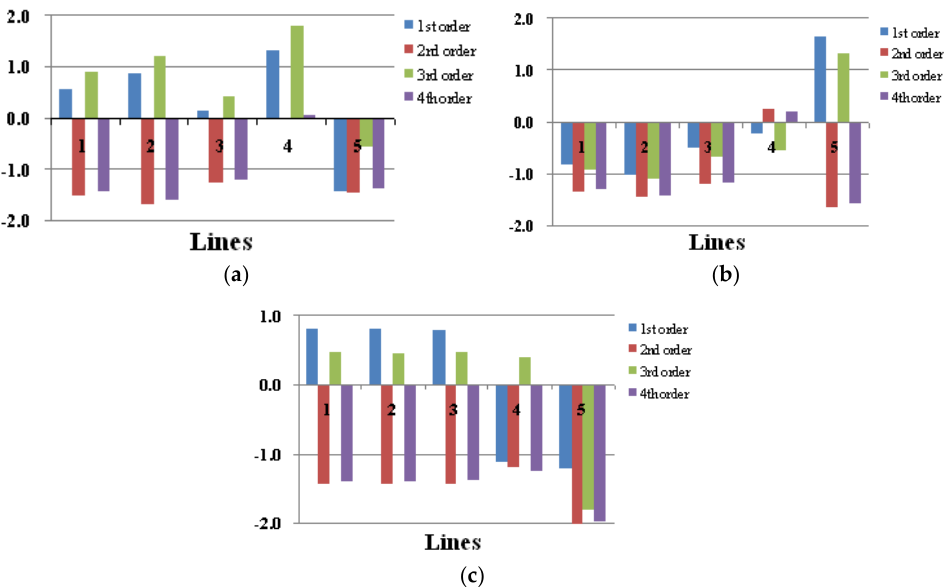
Figure 7. Current distributions of each order for the SLGF on different five lines by using the Z -scores. ( a ) Phase A; ( b ) Phase B; and ( c ) Phase C. Energies 2017 , 10 , 611; 10.3390/en10050611